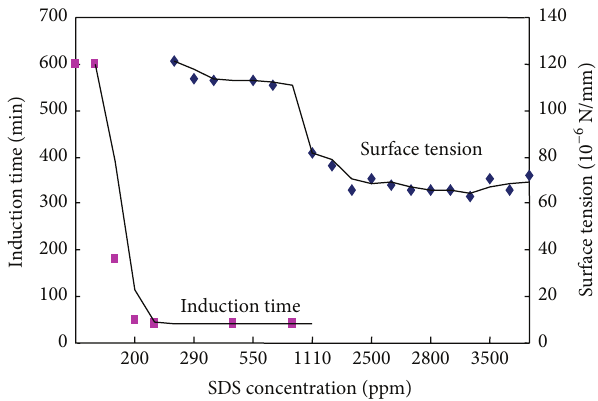
Figure 2: Induction time and surface tension versus SDS concen-